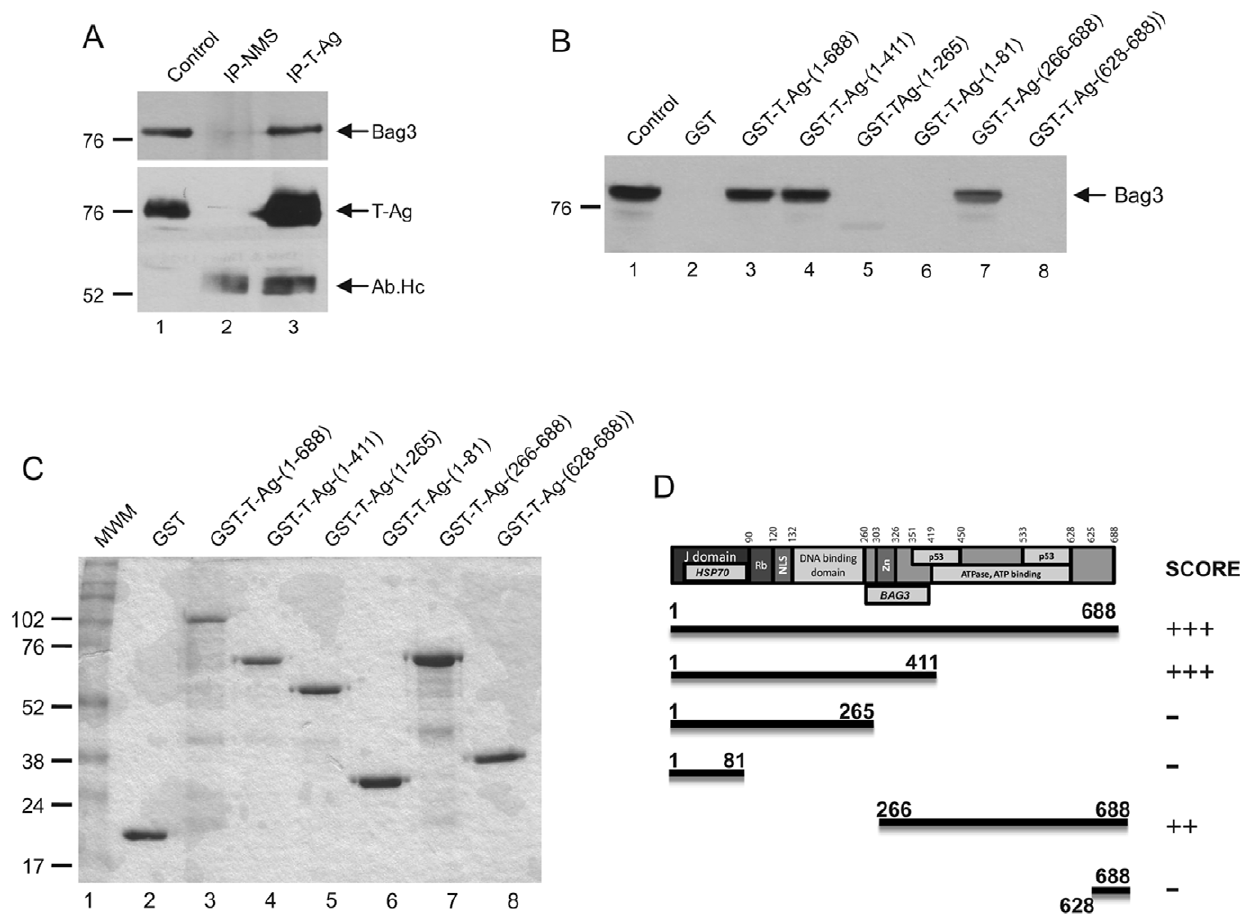
Figure 5. Mapping of Bag3 binding site within T-Ag. A. Bag3 was co-immunoprecipitated with a large T-Ag specific antibody from BSB8 cells as described in Materials and Methods. The Ab.Hc arrow points the heavy chain of the large T-Ag antibody. In lane 1, positive control was whole cell extracts from BSB8 cells used for IPs. B. For GST-pull down assay, full-length T-Ag and its mutant forms were produced in bacteria cells in fusion with GST and after purification, they were incubated with protein extracts prepared from U-87MG cells. Immunocomplexes were separated on a SDS-PAGE and the association of Bag3 with each protein extract was determined by Western blot analysis using a Bag3 specific antibody. C. Coomassie blue staining of bacterially produced protein used in GST-pull down assay. D. Schematic presentation of T-Ag with its various domains and scoring of Bag3 interaction with various T-Ag mutant proteins.